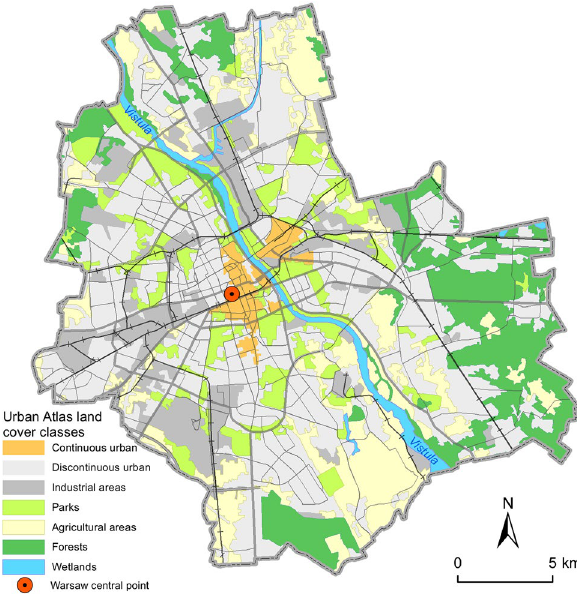
Figure 1. Distribution of green areas and other habitats in Warsaw. The Palace of Culture and Science, assumed as the most central point of the city is